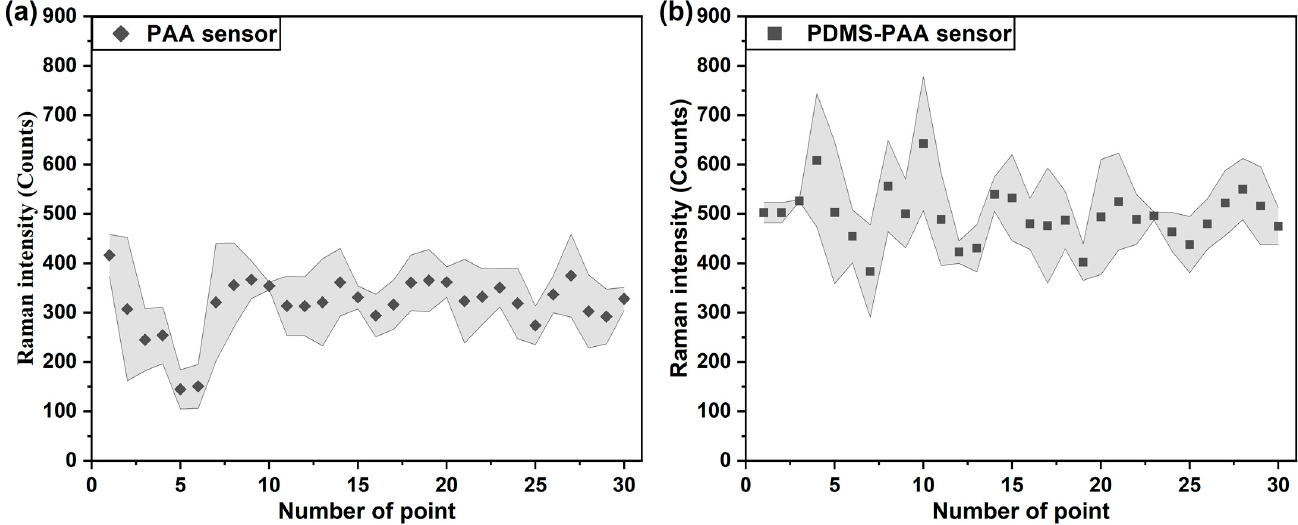
Figure 6. Error band calculated using 30 points obtained from ( a ) PAA-coated and ( b ) PDMS-PAA-coated SERS gas sensor for phenyl ethanol gas